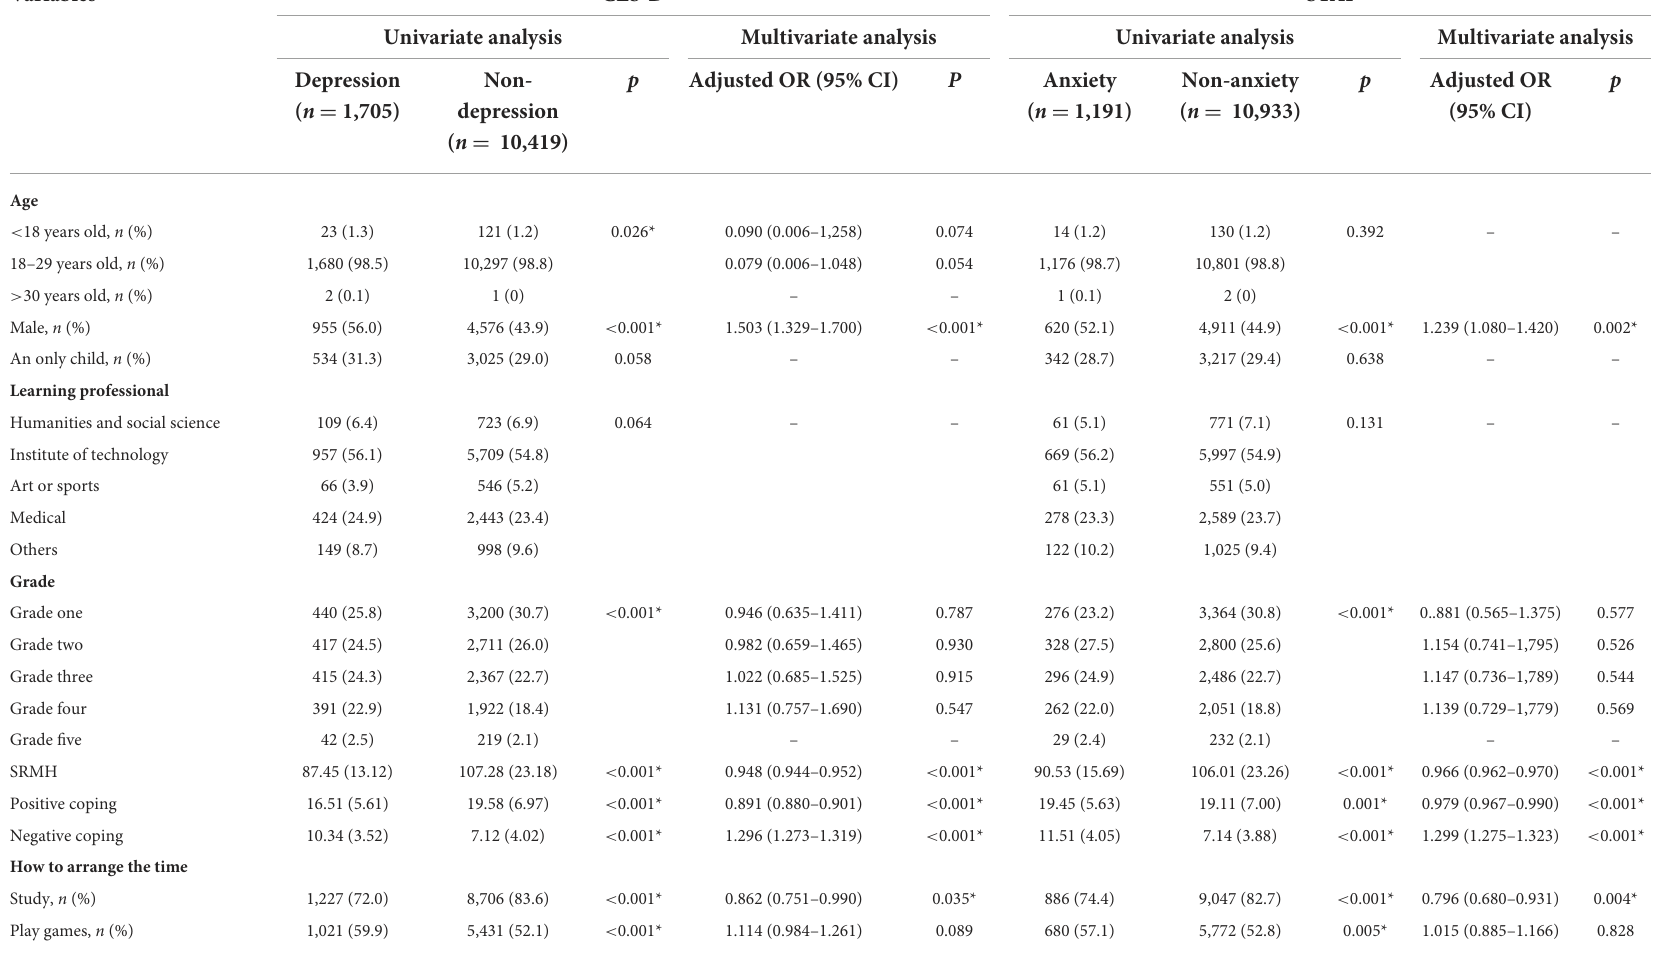
TABLE 1 Univariate and multivariate analysis of participants with and without depression or anxiety symptom. Variables CES-D STAI Univariate